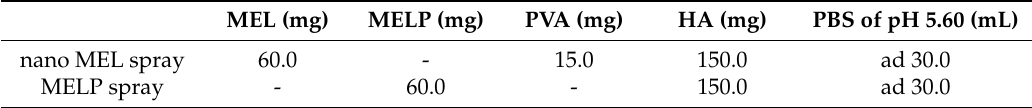
Table 3. Content of intranasal spray